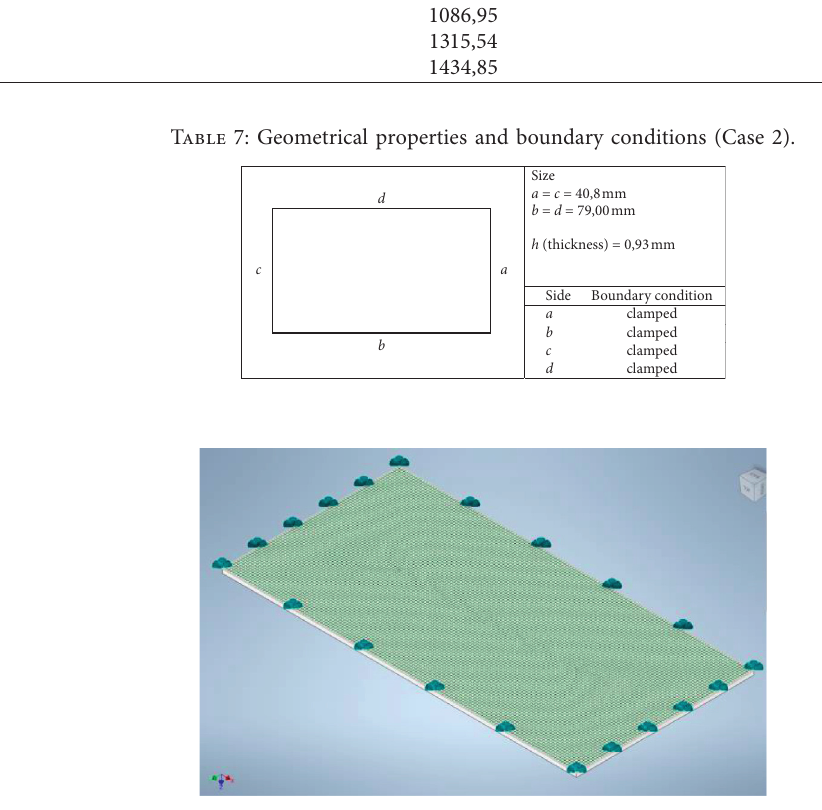
Figure 9: Numerical simulation: mesh and clamped